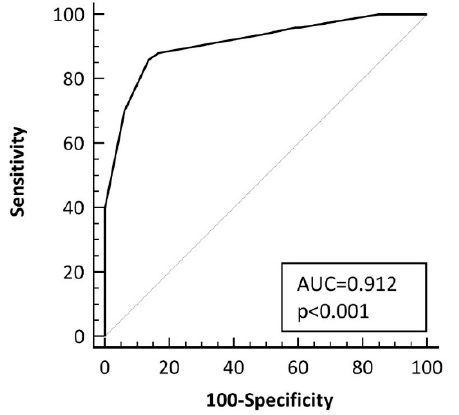
Figure 3. curve for the accuracy of the scoring system at identifying patients with low-grade coeliac enteropathy. AUC: area under the curve, ROC: receiver operating